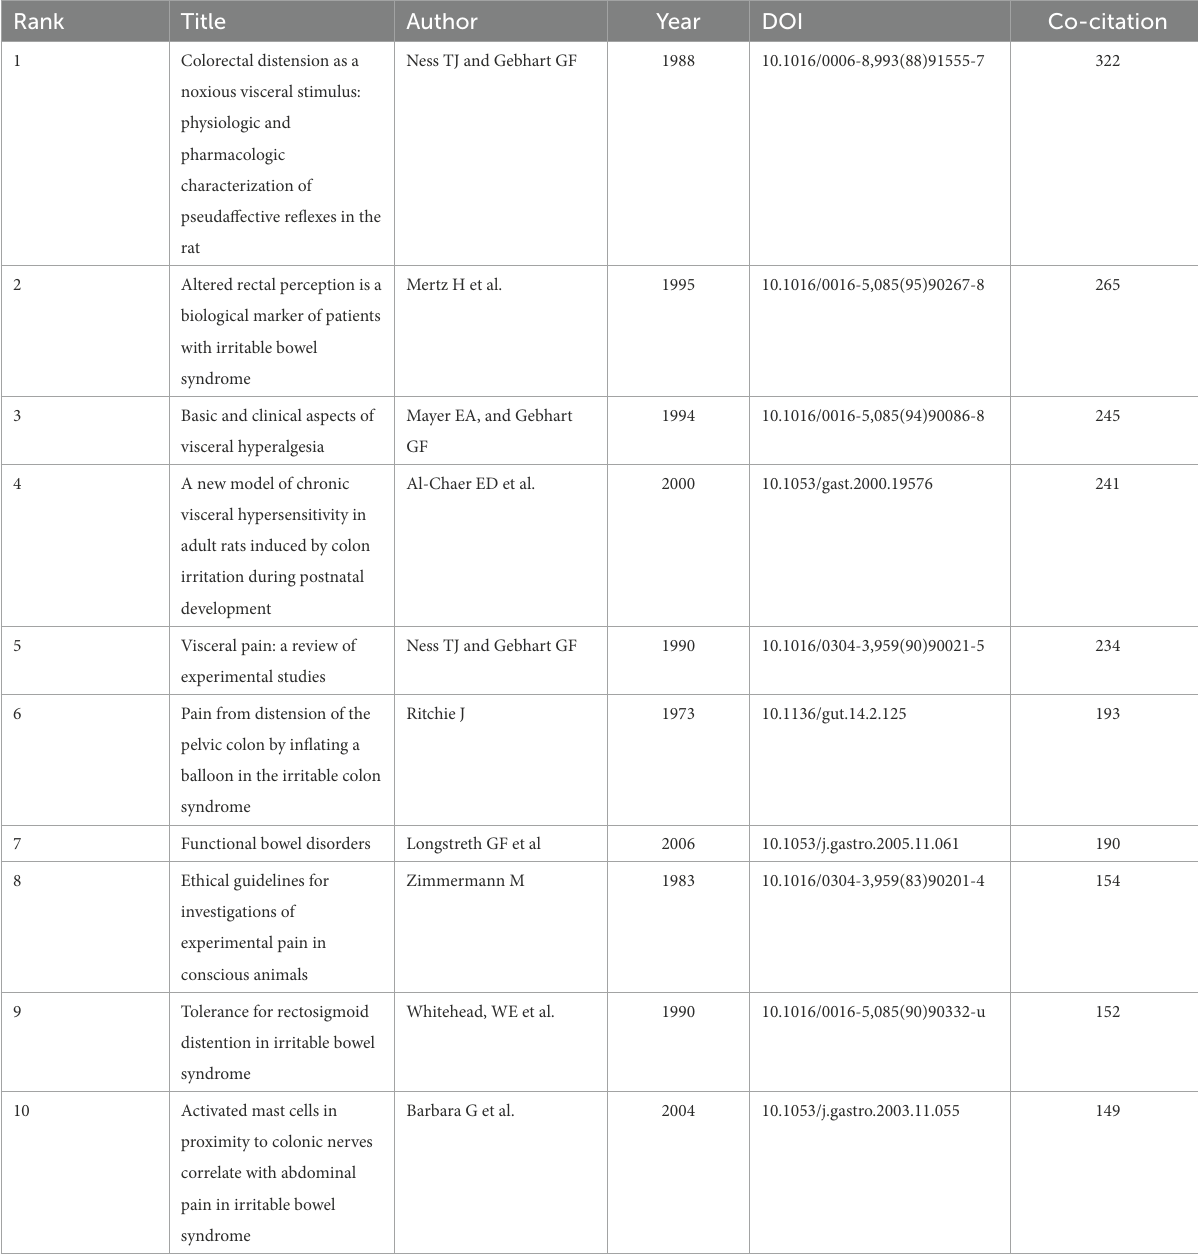
TABLE 5 The top 10 co-cited references on the research of visceral